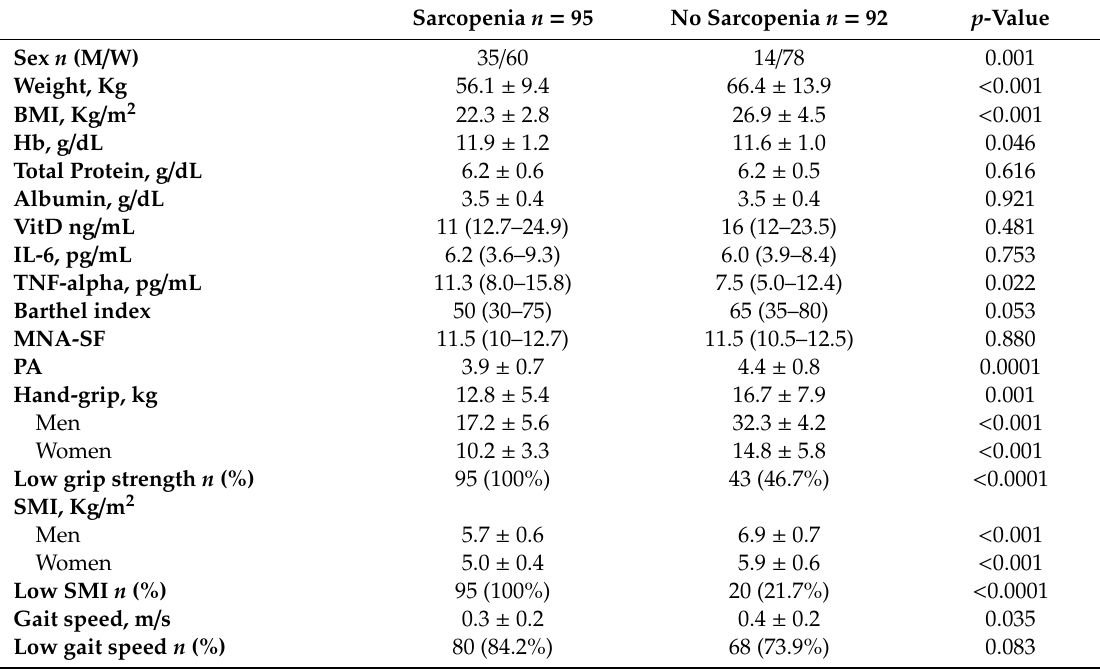
Table 4. Discharge di ff erences in sarcopenic and non-sarcopenic